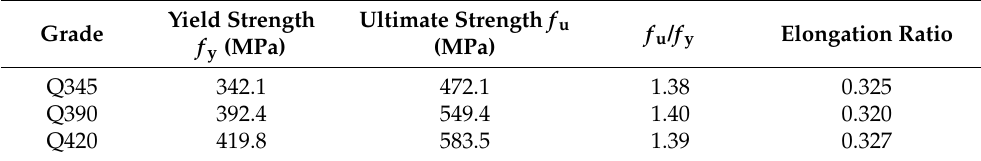
Figure 4. Design details of the L-shaped specimen (unit: cm). ( a ) Front view; ( b ) side view; ( c ) top view. Table 1. Material